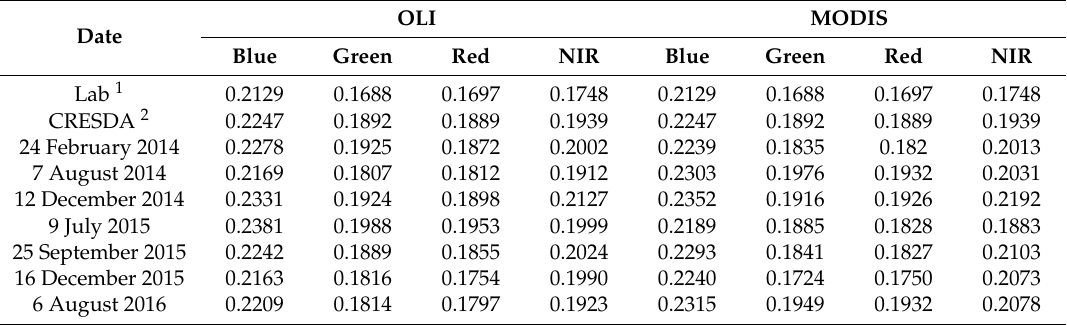
Table 10. Laboratory calibration coefficients, CRESDA site calibration coefficients and cross-calibration coefficients calculated in this paper.